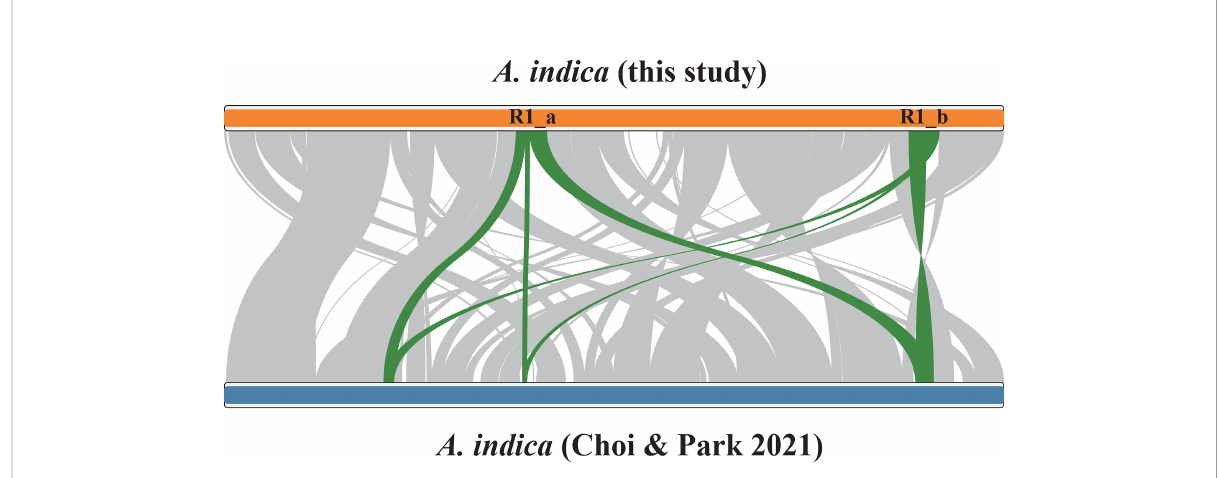
FIGURE 2 Numerous rearrangements between the two Aeginetia indica mitogenomes. The green curve corresponds to the ~16 kb repeat pair (R1) in the A. indica mitogenome of this